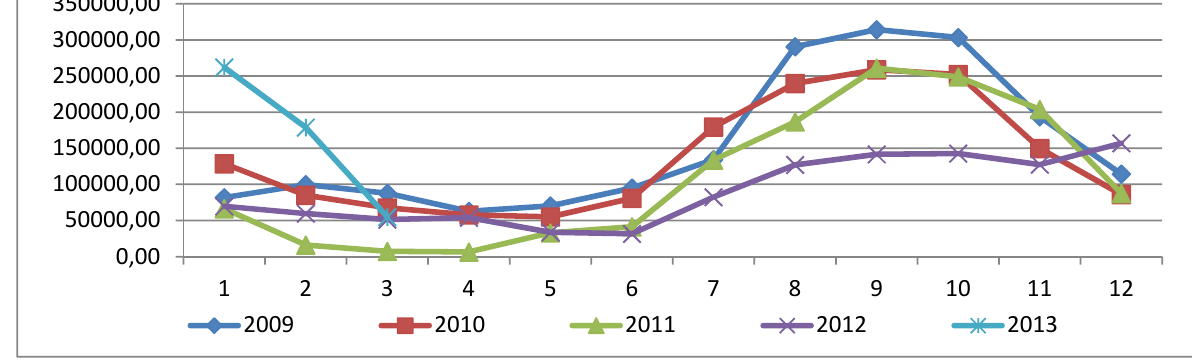
Fig. 4. Acquisition patterns of clove oil until March